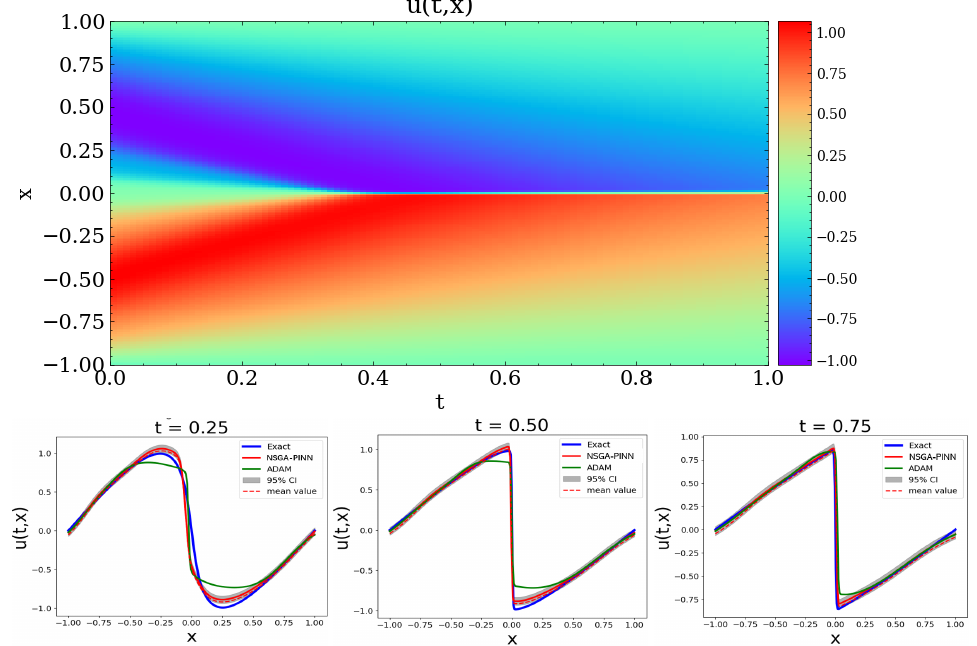
Figure 11. Burgers equation with data noise: the top panel shows the contour plots of solution of the Burgers equation. The lower figure shows the comparison of the exact value with the predicted value at different time points.